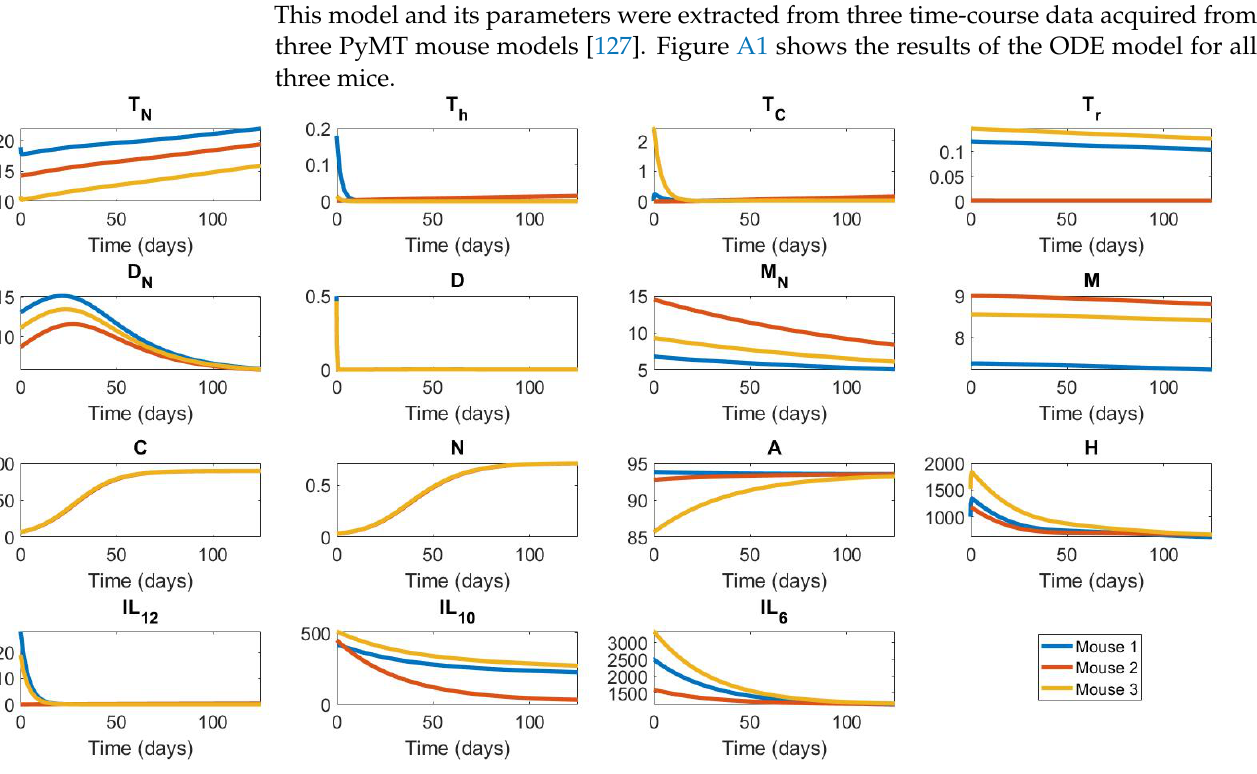
Figure A1. Cells and molecule dynamics from the ODE model